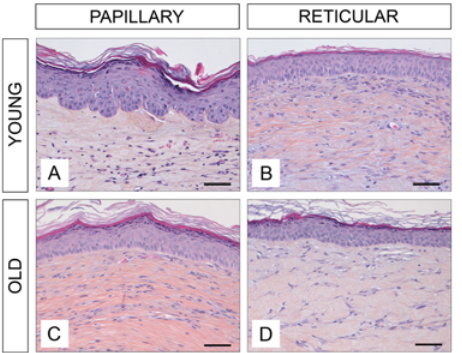
Figure 9. Age-dependent effects of Fp and Fr on the morphology of reconstructed skin after grafting into nude mice. The histology of the different types of three-dimensional reconstructed skin samples was next observed 5 weeks after graft onto nude mice: (A) reconstructed skin containing young Fp; (B) young Fr; (C) old Fp; (D) old Fr. All histological sections were stained with hematoxylin, eosin, and saffron (HES). Scale bars=50 m m.